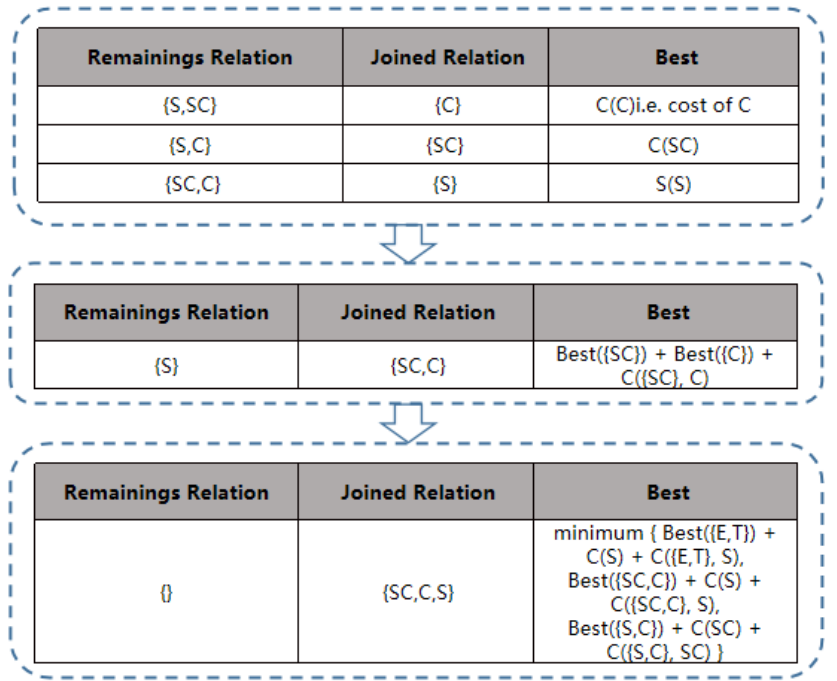
Figure 1. Order of joins regarding the three table relations. (C(R i ) denotes the cost of coming to access the basic relation R i , and C(R i ,R i + 1) denotes the cost of R i and R i + 1